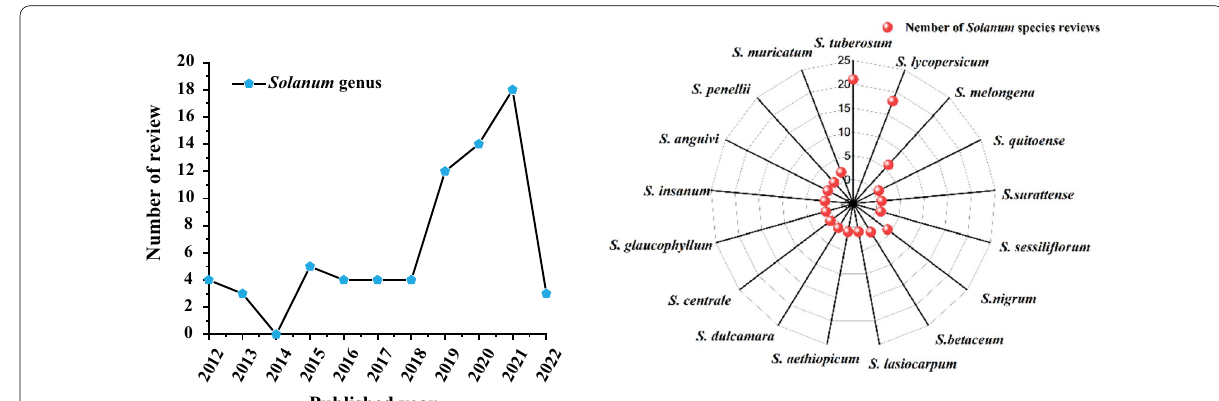
Fig. 1 Reviews of Solanum species published in last ten years